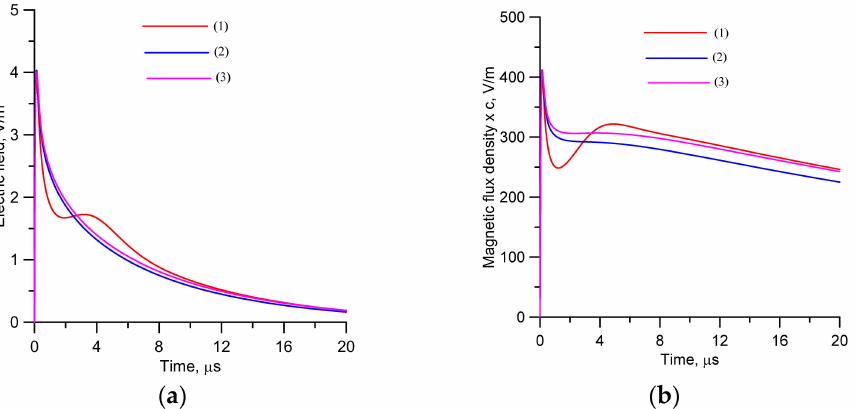
Figure 9. The source electric field ( a ) at 100 km and the source magnetic field ( b ) at 1 km generated by the return stroke for three profiles of the corona discharge time constant. (1) τ ( z ) = τ 0 + τ s ( 1 − e − z 2 / λ 2 ) (2) τ ( z ) = τ 0 (3) τ ( z ) = τ 0 + 0.25 × 10 − 9 z